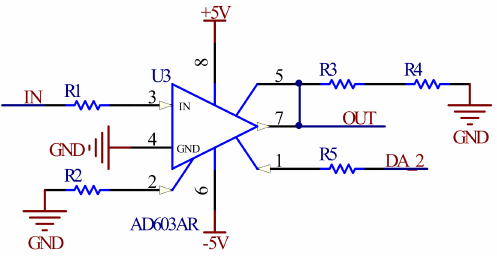
Figure 9. Automatic gain